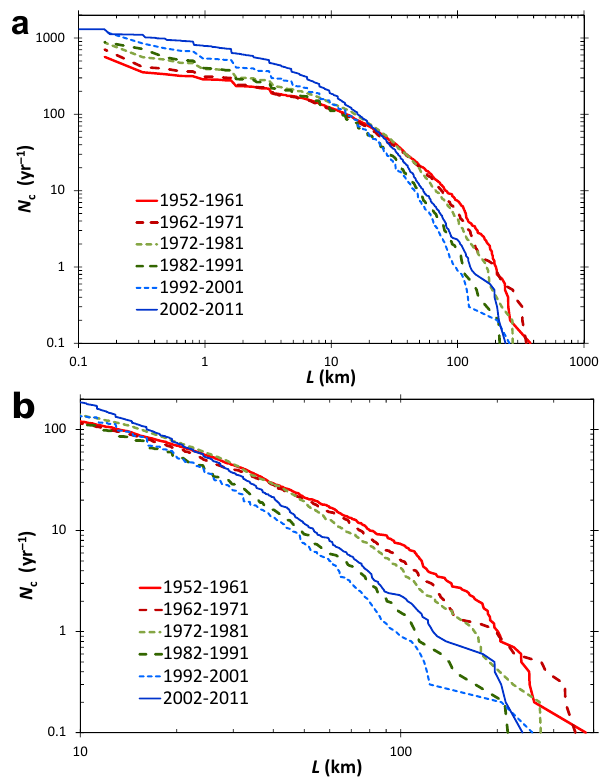
Fig. 1. Cumulative number of continental USA tornadoes per year N c with path lengths greater than or equal to L , given as a function of L . Data are given for six 10-yr periods from 1952–2011. (a) All tornadoes. (b) Data for L ≥ 10km, which is one definition we use in this paper as a severe tornado. Tornado path length data L are from NOAA (2012).